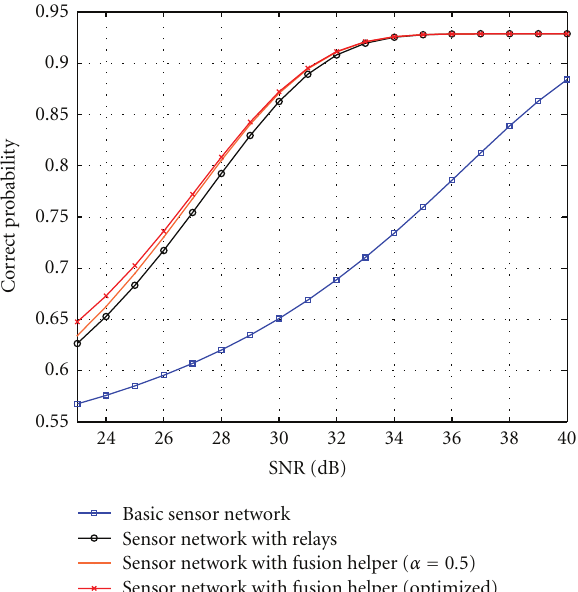
Basic sensor network Sensor network with relays Sensor network with fusion helper ( α = 0 . 5) Figure 6: Theoretical correct probability of the overall decision for di ff erent sensor networks under the AND combining rule in Gaussian channels ( A = 0 . 95, β = 3 . 5, d = 10, π 0 = π 1 = 0 . 5).